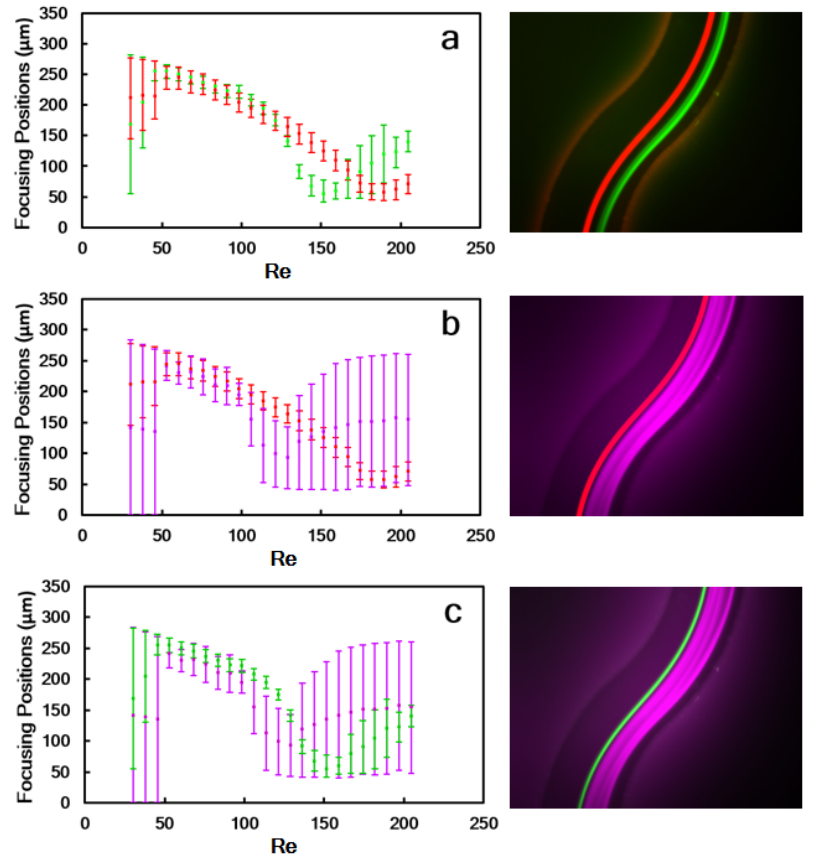
Figure 4. Focusing position of combinations of microparticles of diameter ( a ) 20 µm and 15 µm, ( b ) 20 µm and 10 µm, and ( c ) 15 µm and 10 µm at the transition region versus Reynolds number (left column), and particle streams for optimum separation or enrichment potential at Reynolds numbers of 144, 121 and 121, respectively (right column). Error bars indicate the width of the focusing streak.